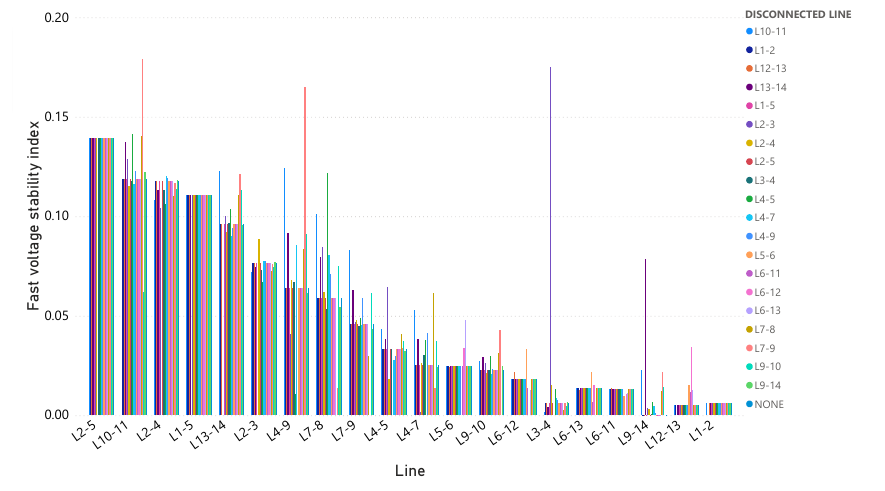
Figure 2. Fourteen-bus-bar system: FVSI for every contingency scenario.